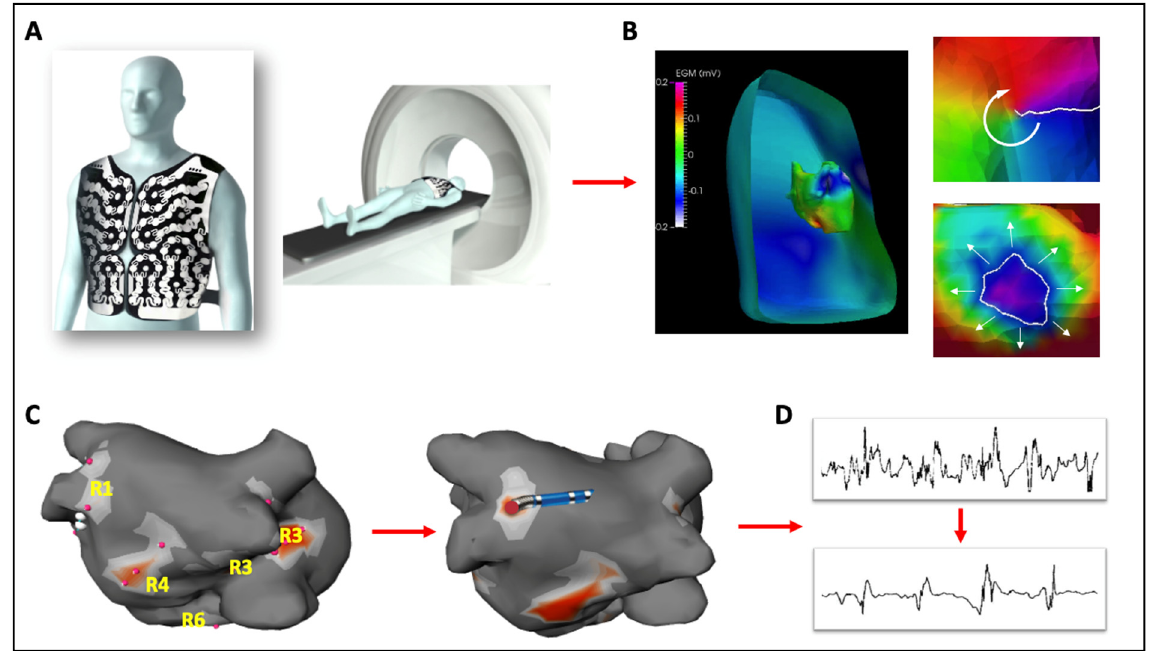
Figure 1. ECGi mapping approach. A 252 body-surface electrode array, combined with thoracic CT imaging ( A ) allows for the depiction of virtual cardiac potentials on the epicardial surface ( B ) and can identify re-entrant ( B , right top panel) and focal activities ( B , right bottom panel) from activation maps generated from unipolar electrograms. The AFACART study used this technique to identify driver sites in both atria which were targeted for ablation ( C ) with the endpoint of converting complex, fractionated signals into simple, discrete signals ( D ). R1-R6 indicate regions where CFAEs were identified.